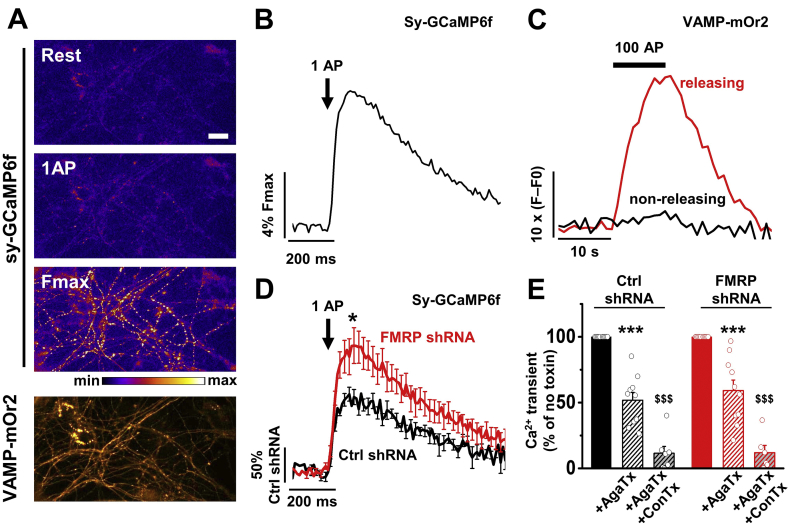
Effect of FMRP knock-down on Ca2+ transients from presynaptic terminals of hippocampal neurons.A) GCaMP6f fluorescence changes in presynaptic terminals of DRG neurons expressing VAMP-mOr2 and sy-GCaMP6f in response to electrical stimulation. Top three panels show sy-GCaMP6f fluorescence: at rest (top), after 1 AP (middle) and after ionomycin application (Fmax, bottom). Scale bar 20 μm. The pseudocolour scale is shown below the third panel. The bottom panel shows presynaptic terminals expressing VAMP-mO2.B) Example of increase of sy-GCaMP6f fluorescence (Ca2+ transients) in response to 1 AP from hippocampal neuron terminals. The trace corresponds to the mean response to 5 single APs from 50 individual boutons. The mean response was normalized to the maximum fluorescence (Fmax) obtained after application of ionomycin (5 μM).C) Example of variation of VAMP-mOr2 fluorescence (F - F0) in response to 100 AP at 10 Hz from hippocampal neuron terminals. Variations of VAMP-mOr2 fluorescence were used to identify vesicular release from presynaptic boutons: each individual bouton was analyzed and grouped into “non-releasing” and “releasing” categories when either no modification or an increase of fluorescence was recorded in response to electrical stimulation.D) Average increase of sy-GCaMP6f fluorescence in response to 1 AP recorded from pre-synaptic terminals transfected with either Ctrl shRNA (black trace) or FMRP shRNA (red trace). The Ca2+ transient was expressed as ΔF/F0 and normalized to the averaged peak in the Ctrl shRNA condition. Peak values are 100.0 ± 10.7% (n = 9) and 177.4 ± 25.5% (n = 10, P = .02) for Ctrl shRNA and FMRP shRNA, respectively. Average sy-GCaMP6f responses (mean ± SEM) to 1 AP correspond to 5–6 trial average from 50 to 75 boutons. n numbers correspond to independent experiments. *P < .05, one-way ANOVA and Bonferroni post-hoc test.E) Effect of specific calcium channel blocker application on the amplitude of the Ca2+ transient in response to 1 AP. Average Ca2+ transients were normalized to their respective no toxin peak in Ctrl shRNA and FMRP shRNA condition. The remaining Ca2+ transient in response to 1AP after treatment with AgaTx (300 nM; P/Q-type calcium channel blocker) was 51.8 ± 6.0% (n = 10) in Ctrl shRNA and 59.2 ± 8.0% (n = 10, P = .5, one-way ANOVA) in FMRP shRNA. In a subset of experiments, ConTx (1 μM; N-type calcium channel blocker) was added to the perfusion 11.5 ± 5.2% (n = 7) and 12.0 ± 5.5% (n = 6) of the Ca2+ transients remained for Ctrl shRNA and FMRP shRNA, respectively. Average sy-GCaMP6f responses (mean ± SEM) to 1 AP correspond to 5–6 trial average from 50 to 75 boutons. n numbers correspond to independent experiments. Open circles (black and red) represent individual experiments. *** P < .001, vs no toxin, paired t-test; $$$P < .001, vs + AgaTx, one-way ANOVA and Bonferroni post-hoc test. (For interpretation of the references to color in this figure legend, the reader is referred to the web version of this article.)